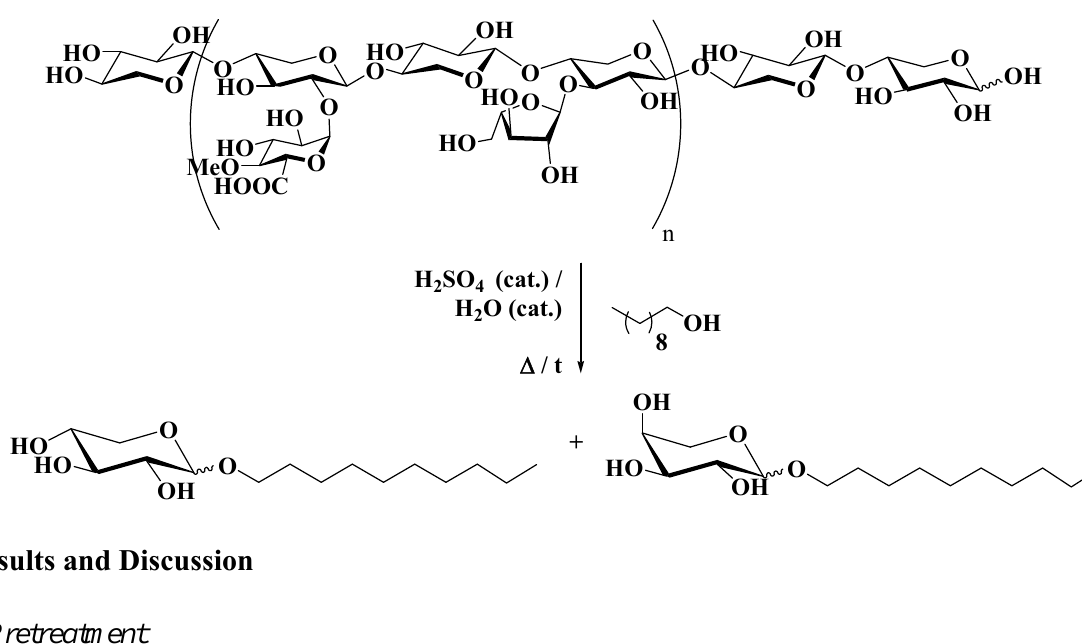
Scheme 1. Wheat straw hemicellulose conversion into decyl glycosides (glucosides and furanosides are omitted for